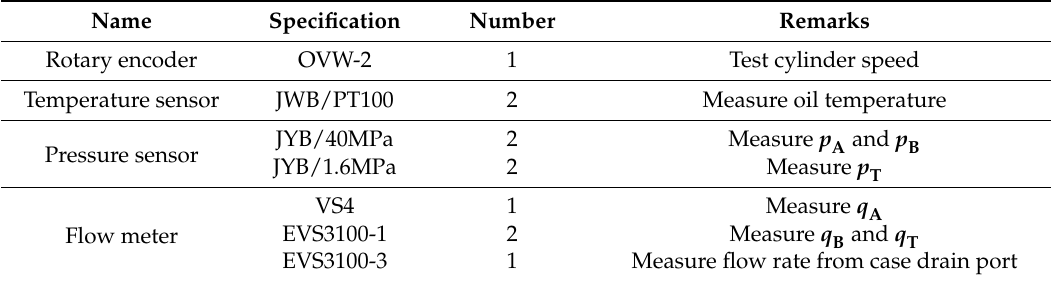
Figure 5. Schematic of the experimental system. Table 1. Details of the sensors and equipment used in the test of the inclined-axis hydraulic transformers.